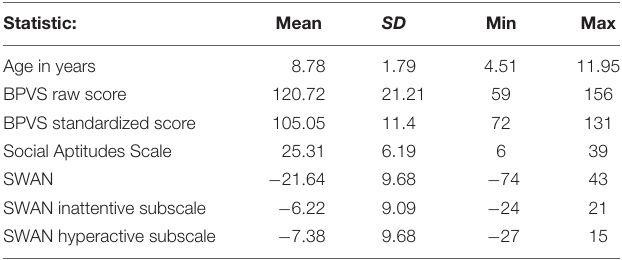
TABLE 1 | Descriptive statistics for the